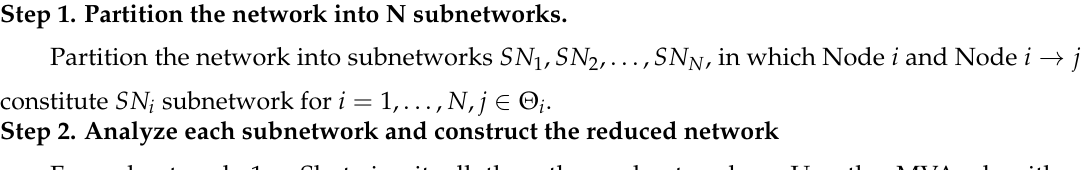
Algorithm 2 Flow equivalent server (FES) algorithm for closed queuing